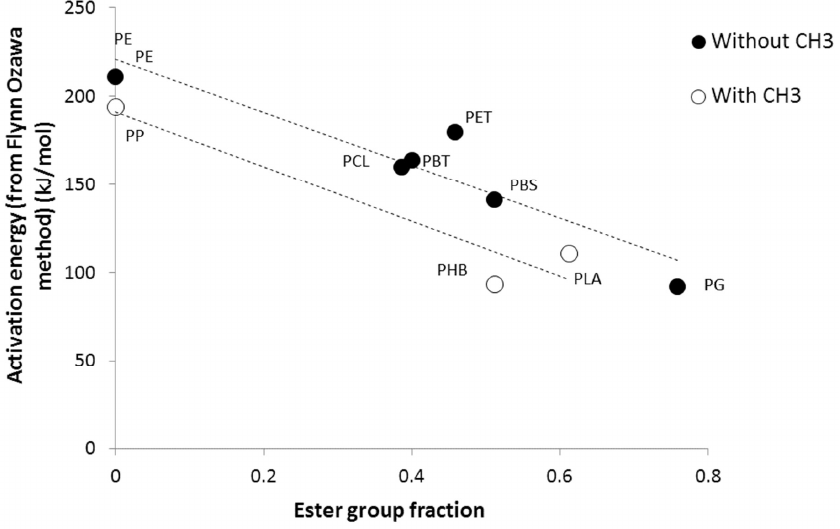
Figure 4. Activation energy (from the Flynn-Wall-Ozawa method) versus ester group fraction/ for Figure 4 – Activation energy (from Flynn-Wall-Ozawa method) versus ester group function for polymers with or without a CH 3 group. polymers with or without a CH 3 group